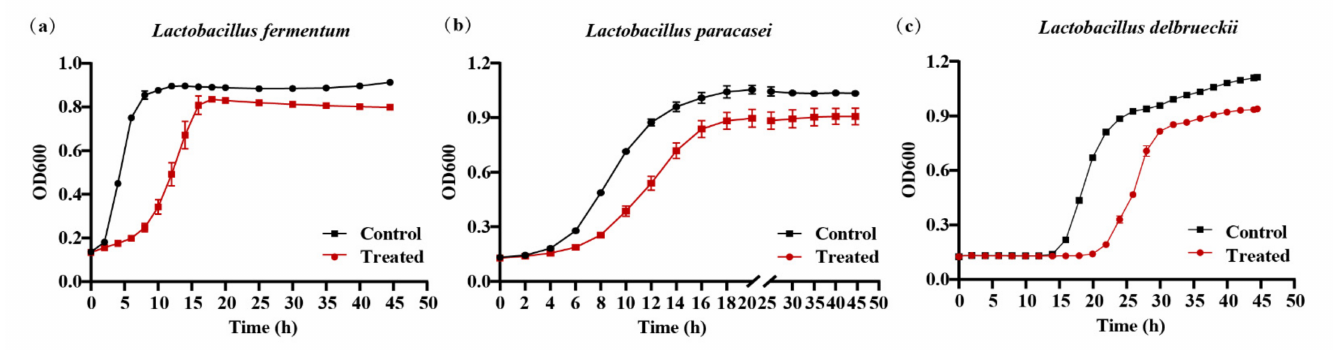
Figure 5. 020402_LYZ M1 affects the growth of Lactobacillus . ( a ) Growth curve of Lactobacillus fermentum . ( b ) Growth curve of Lactobacillus paracasei . ( c ) Growth curve of Lactobacillus delbrueckii